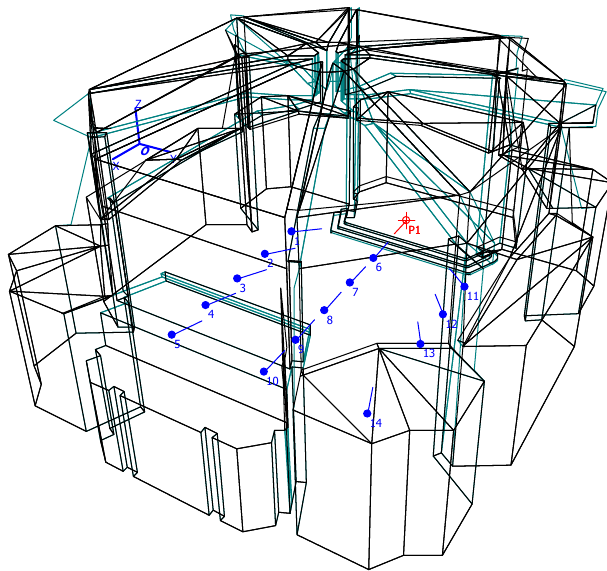
Figure 7. 3D virtual model with the software “Odeon”. Table 3. Sound absorption coe ffi cient values of the empty seats.